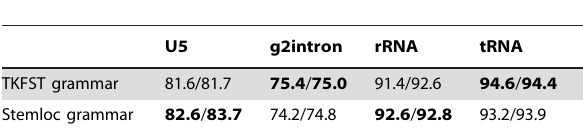
Table 5. Percentage sensitivity and positive predictive value (Sensitivity/PPV) for pairwise nucleotide-level alignments in the BRalibaseII benchmark.